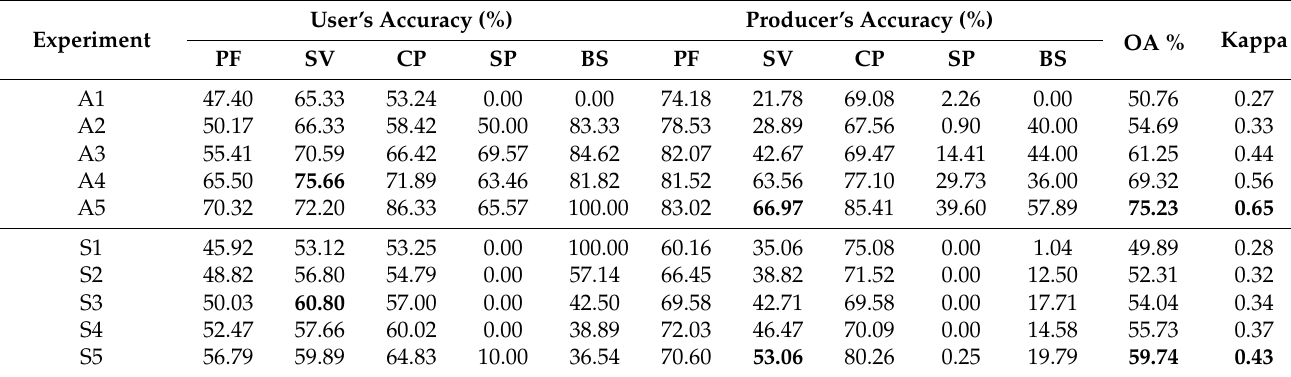
Table 4. Overall accuracy (OA) and Kappa coefficient for the Support Vector Machine classifi- cation experiments involving ALOS/PALSAR-2 and Sentinel-1 data sets. PF = primary forest; SV = secondary vegetation; CP = clean pasture; SP = shrubby pasture; BS = bare soil. See details of the experiments in Table 1.